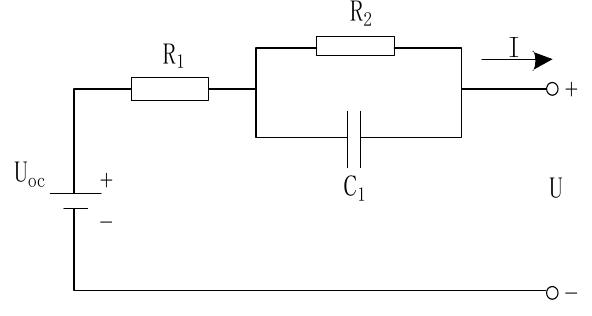
Figure 9. Thevenin equivalent circuit model.